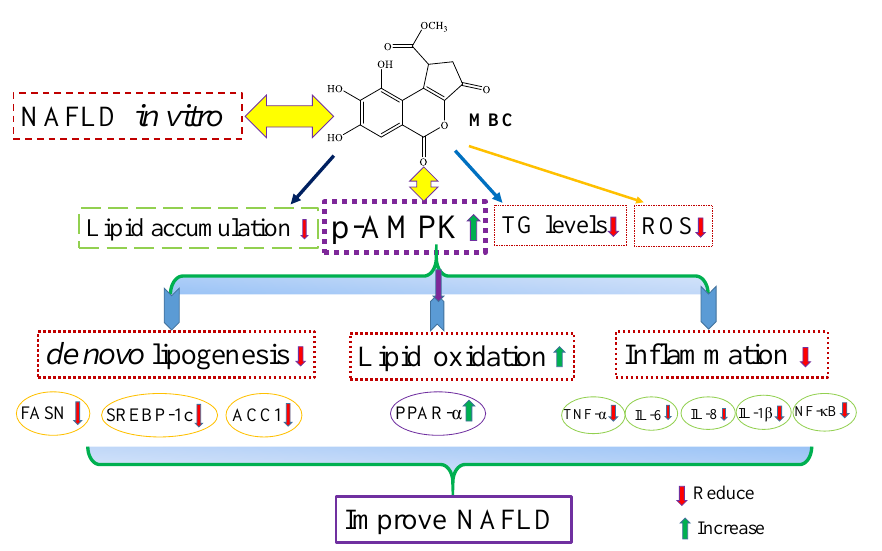
Figure 5. Schematic presentation of methyl brevifolincarboxylate (MBC) effect on NAFLD in vitro.